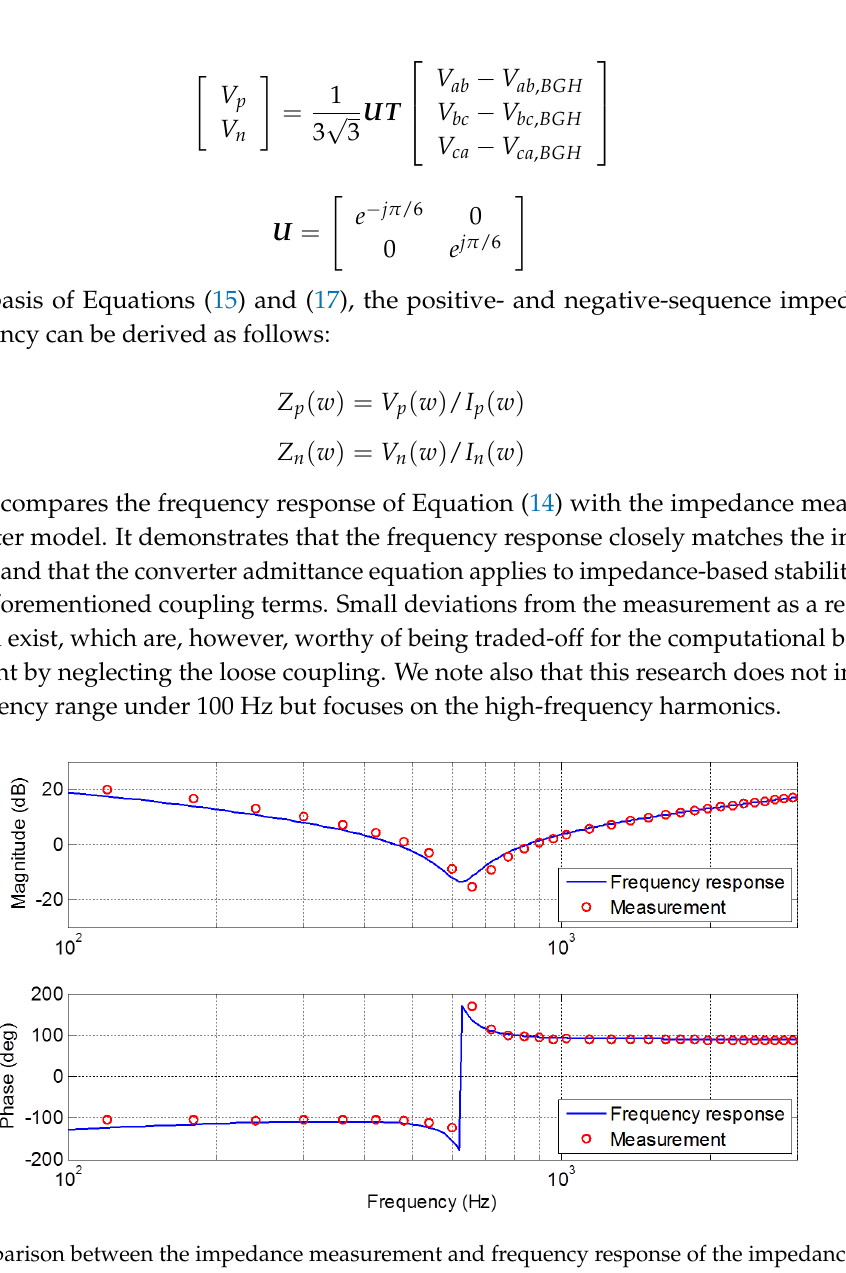
Figure 7. Comparison between the impedance measurement and frequency response of the impedance